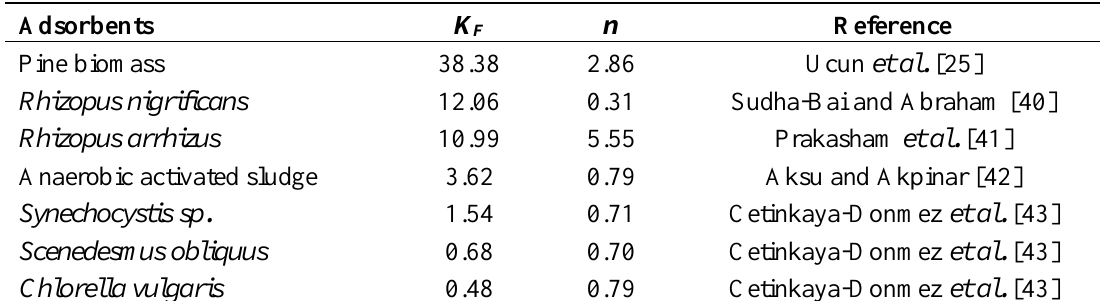
Table 3 Freundlich constants corresponding to various adsorbent materials used to retain Cr(VI) in previous